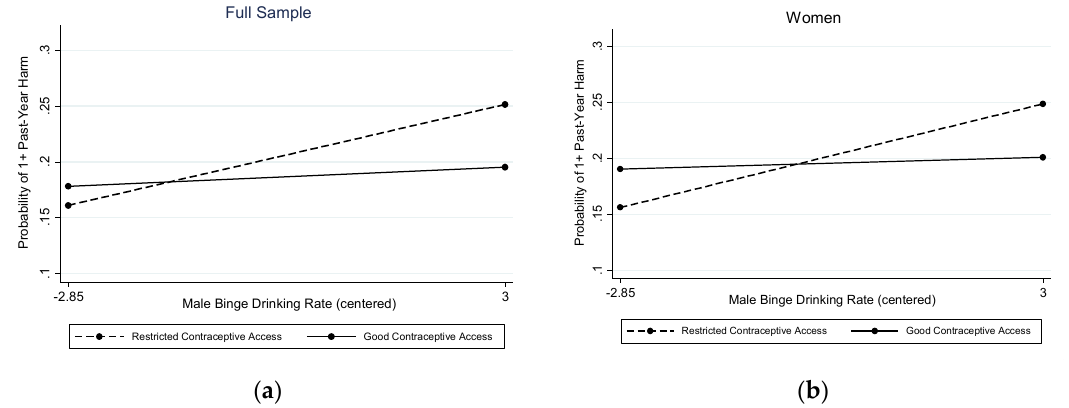
Figure 1. Interaction between male binge drinking rate and contraceptive access in relation to any second ‐ hand harm from alcohol in the past year: ( a ) in the full sample (left panel); and ( b ) for women (right panel).